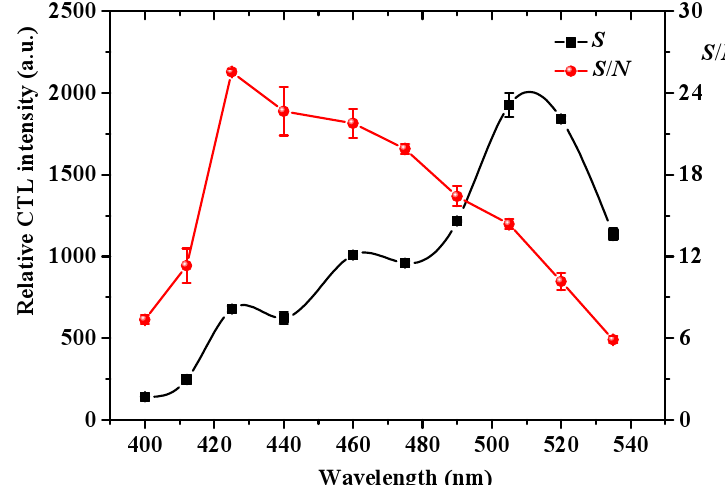
Figure 3. The effect of detecting wavelength on the relative CTL intensity and signal-to-noise ratio ( S / N) . Temperature: 200 °C, air flow rate: 80 mL/min, concentration: 1.2 mg/L. Error bars stand for ± S.D.